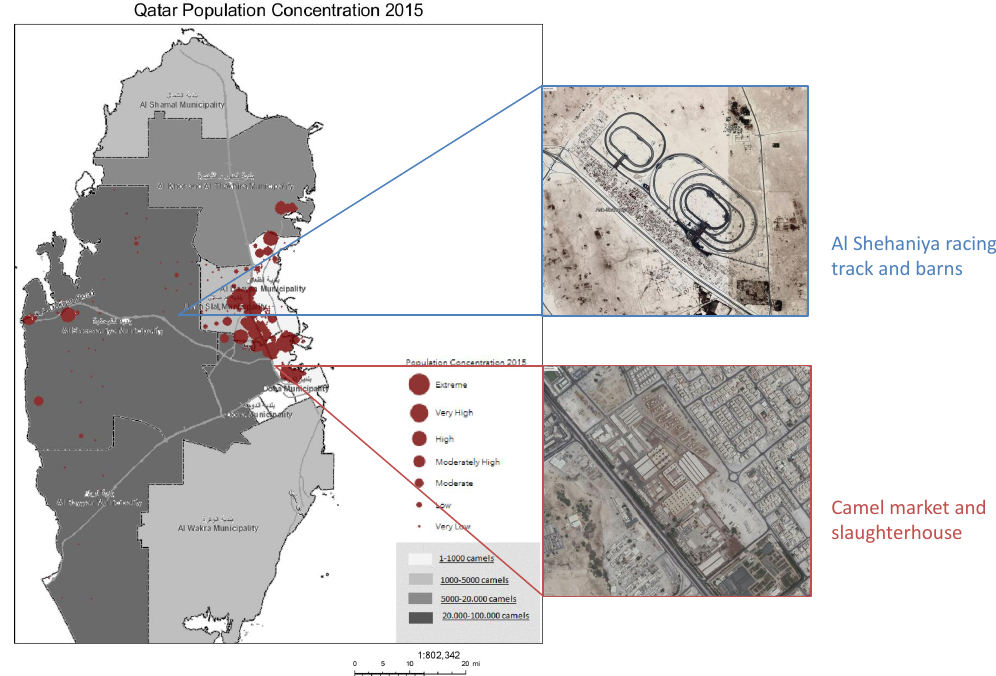
Figure 3. Human and camel density map of Qatar (adapted from Ministry of Development Planning and Statistics, Population Concentration map, 2015). The density map shows the density of camels (source: Ministry of Municipality and Environment) and humans in Qatar. Most people live in and around Doha, where the Doha animal market and slaughterhouse are also located. The highest camel density can be found in the Al-Rayyan area, where the Al-Shehaniya racing tracks are also located. A small, but growing, part of the Qatar population also lives in the Al-Rayyan